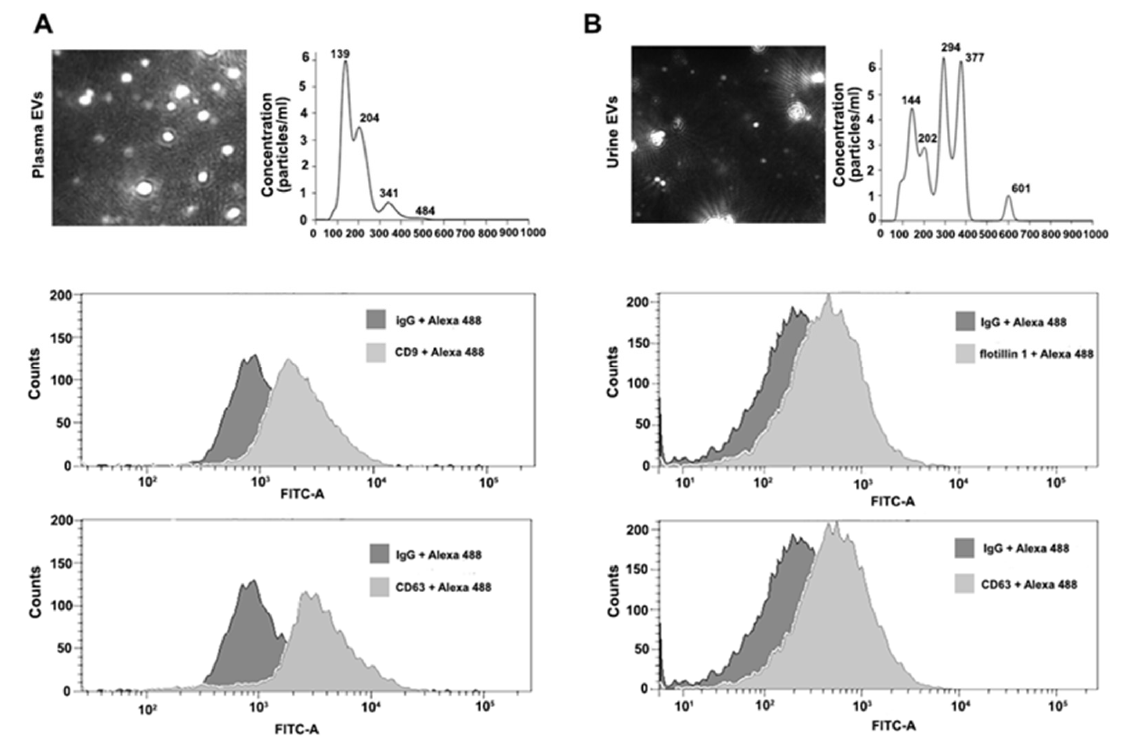
Figure 2. Characterization of plasma and urine EVs isolated by ExoGAG technology. ( A ) Representative image of NTA profile showing concentration (particles/mL) and size (nm) of plasma EVs (upper panel). Representative profiles of flow cytometry assays for plasma EVs. Alexa 488 fluorescence was used as secondary antibody and non-specific IgG as negative control of fluorescence. Positive CD9 and CD63 labelling is represented by a displacement of fluorescence peak curve (lower panels). ( B ) NTA profile of harvested urine EVs expressed as concentration (particles/mL) and size (nm) (upper panel). Flow cytometry analysis of urine EVs resulted in a positive flotillin 1 and CD63 labelling represented by a displacement of fluorescence peak curve (lower panels).